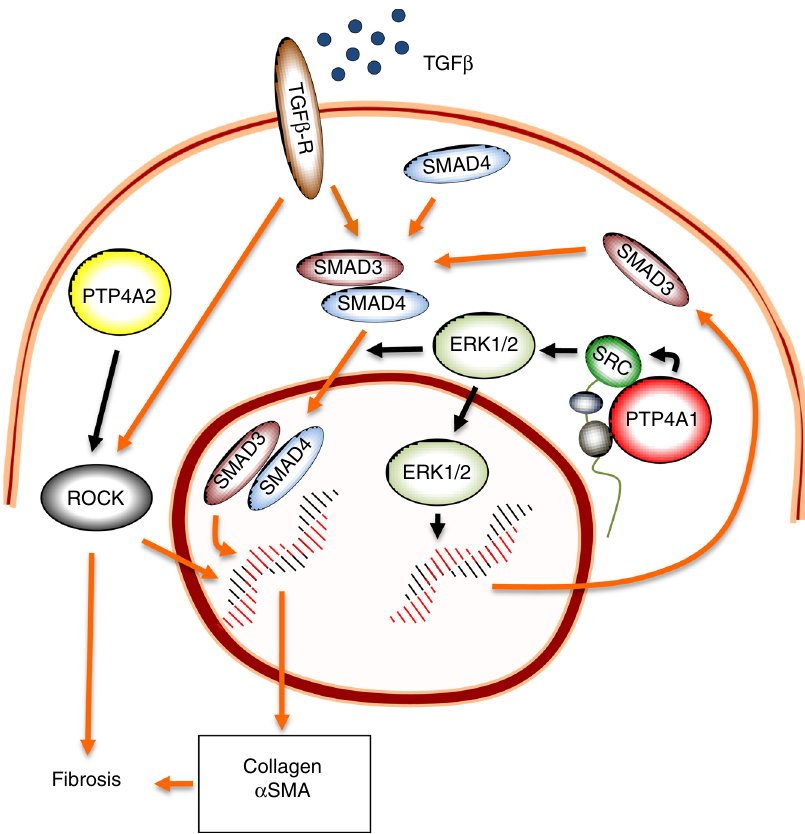
Fig. 8 PTP4A1 promotes TGF β signaling in DFs. PTP4A1 interacts with SRC and promotes SRC half-life, which in turn enhances activation of the MAPK pathway. Activated ERK1/2 induces transcription of SMAD3 and promotes TGF β -driven SMAD3 nuclear translocation, which boosts pro- fi brotic TGF β signaling. PTP4A2, despite its high identity with PTP4A1, does not interact with SRC or affect the MAPK – SMAD3 pathway. However, it also promotes pro- fi brotic signaling, perhaps through selective activation of the ROCK pathway. Orange continuous connectors: TGF β signaling pathways. Black connectors: PTP4A1/PTP4A2 functions in human